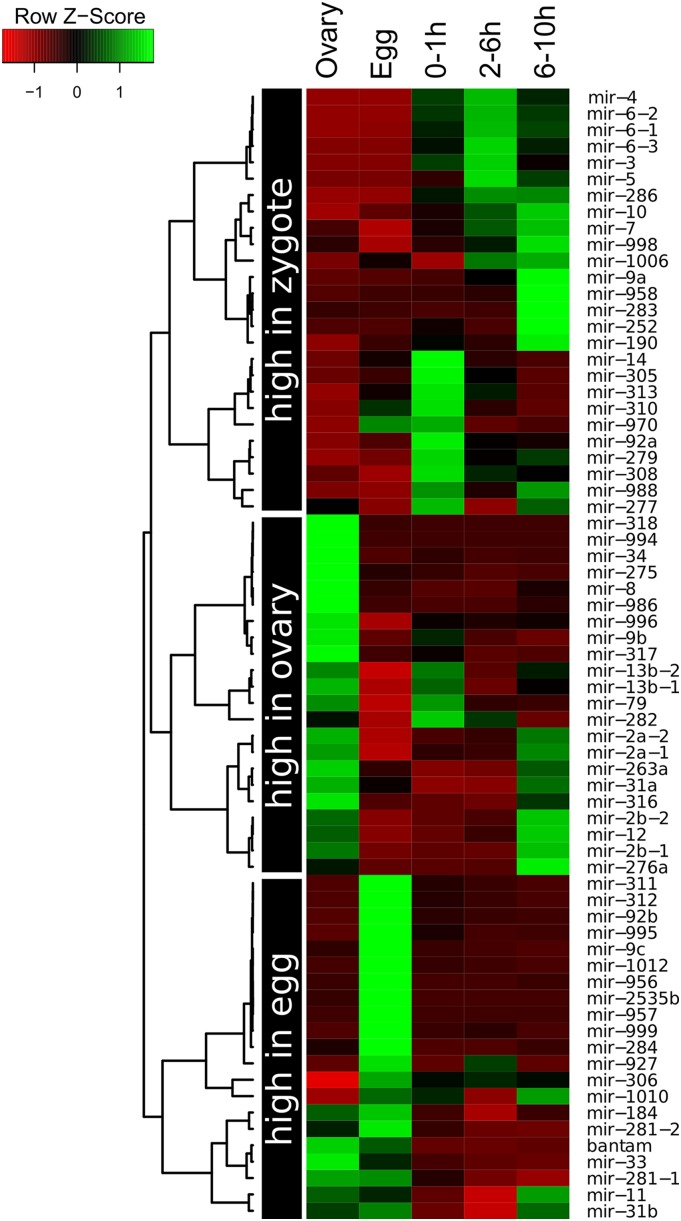
Expression profile of maternal microRNAs in Drosophila melanogaster. The hierarchical tree is split into three categories of microRNAs: high abundance in ovaries compared with the other stages; those that are mainly present in the unfertilized eggs; and those that have a greater expression level later during development.